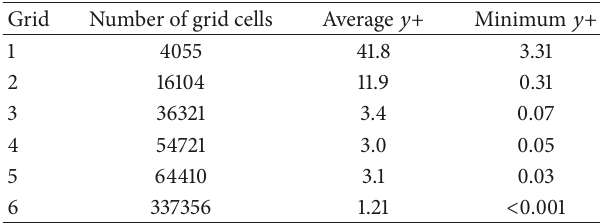
Table 2: The properties of the computational meshes used in the